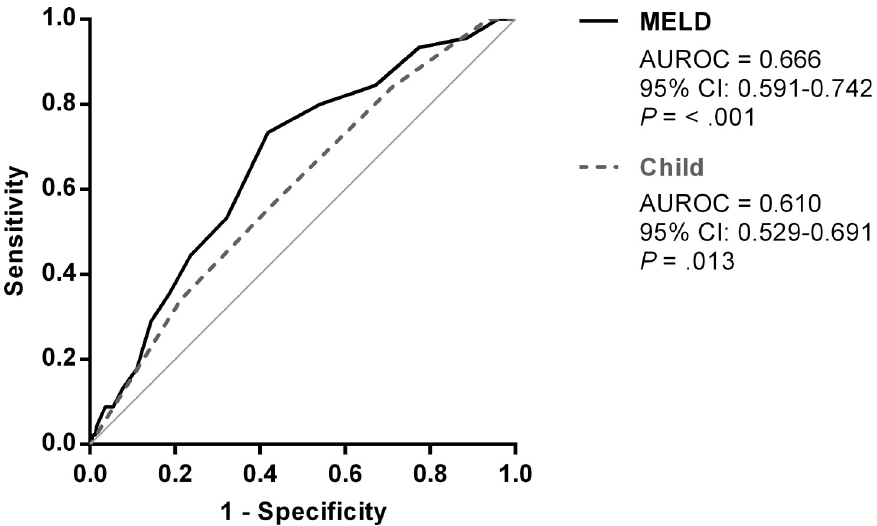
Fig 2. ROC curves for Child–Pugh scores of 5–9 and the corresponding MELD scores for predicting bacterial infection. The AUCs were 0.610 (95% CI: 0.529–0.691, P = 0.013) and 0.666 (95% CI: 0.591–0.742, P < 0.001) for the Child–Pugh and MELD scores, respectively. Abbreviations: ROC, receiver operating characteristic; AUC, area under the ROC curve; MELD, model for end-stage liver disease; CI, confidence interval.